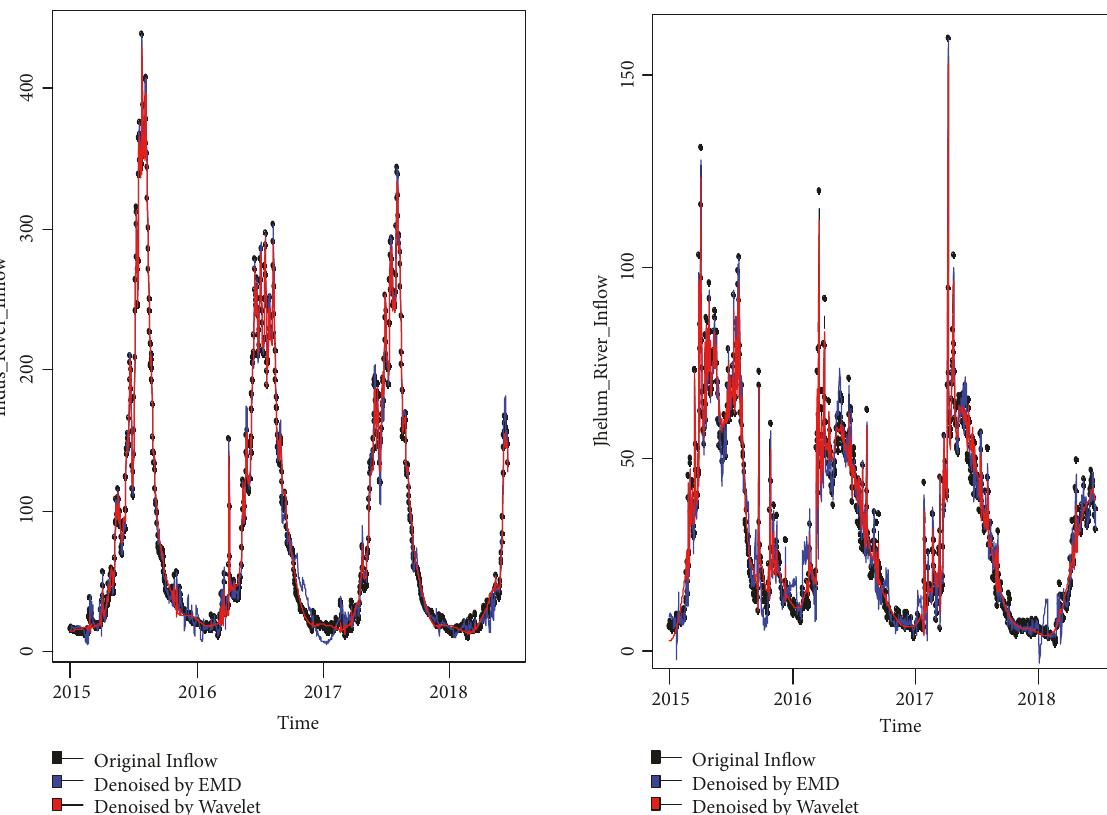
Figure 5: The denoised series of the two hydrological time series of Indus and Jhelum rivers inflow. The figure shows the denoised results obtained through the EMD-based threshold method (in red color) and the wavelet analysis-based threshold method (in blue color).